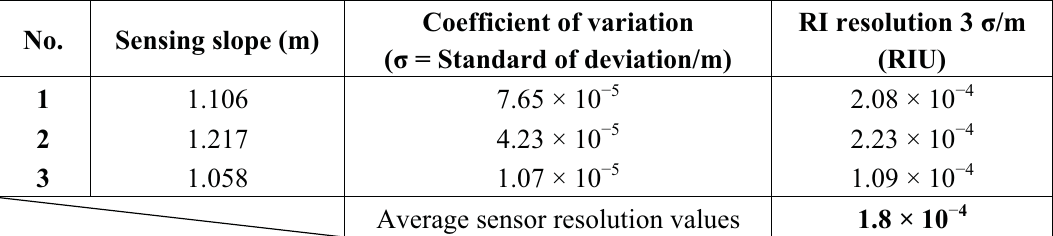
Table 6. The sensing experiment results for ATR fiber